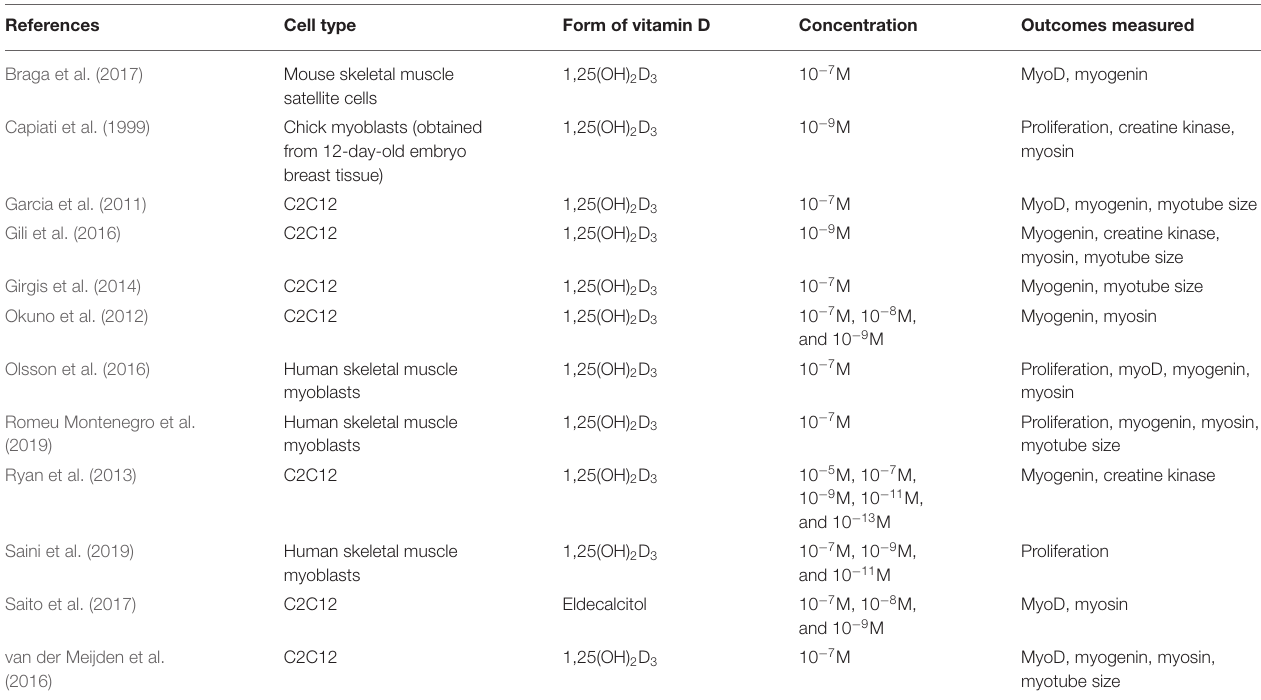
TABLE 2 | Summary of study